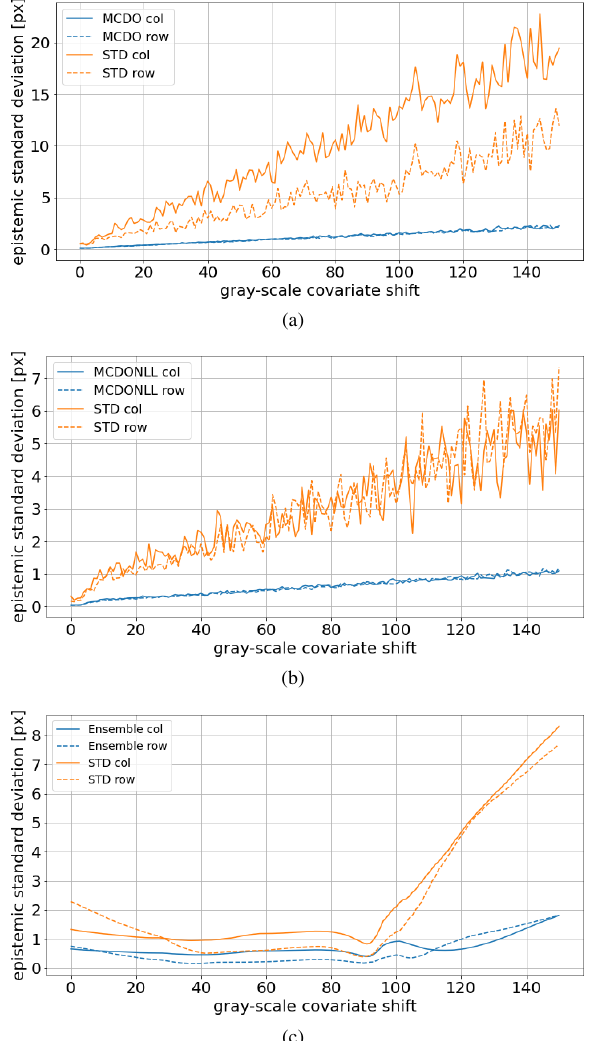
Figure 6. Epistemic standard deviation estimates in image columns and rows in pixel units with (a) MCDO, (b) MCDONLL, and (c) Ensemble under covariate shift in case of